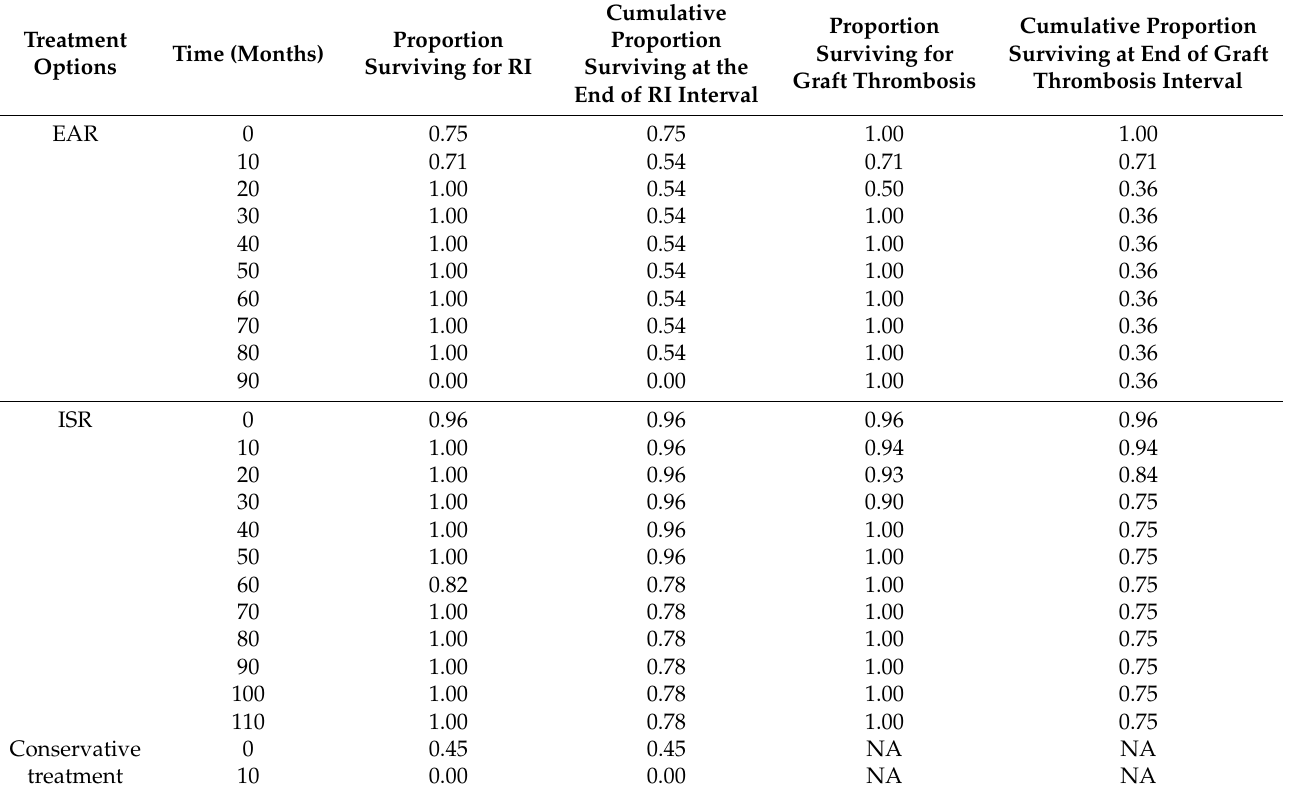
Table 6. Survival table of the RI and graft thrombosis situation in AGI